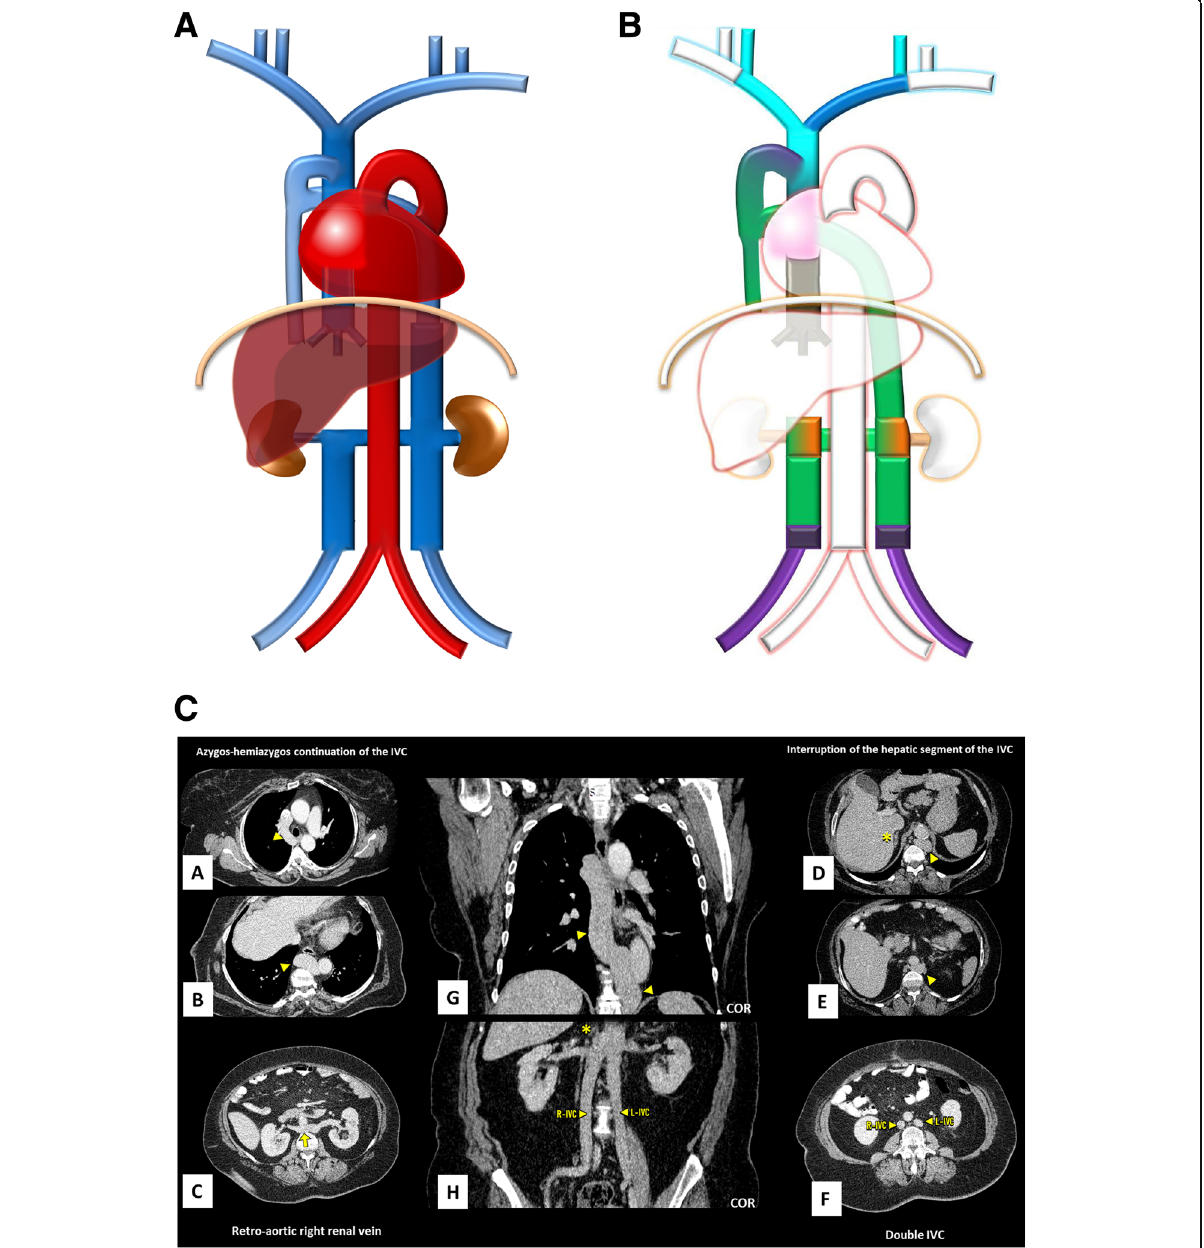
Fig. 13 a Coexistence of multiple venous development anomalies schematic. Case of a double IVC with a retro-aortic right renal vein, interruption of the hepatic segment and hemiazygos continuation of the IVC. b Coexistence of multiple venous development anomalies embryology schematic. Resulting from the persistence of the left supra cardinal veins and the left sub-supracardinal anastomosis, regression of the right vitelline- sub cardinal anastomosis, together with persistence of the dorsal arch and regression of the ventral arch of the renal collar. c Coexistence of multiple venous development anomalies imaging. Contrast-enhanced CT scan showing a double IVC (R-IVC, L-IVC) [F] with a retroaortic right renal vein (arrow) [C], interruption of the hepatic segment (asterisk) [D, H] and hemiazygos continuation of the IVC (triangle) [A, B,